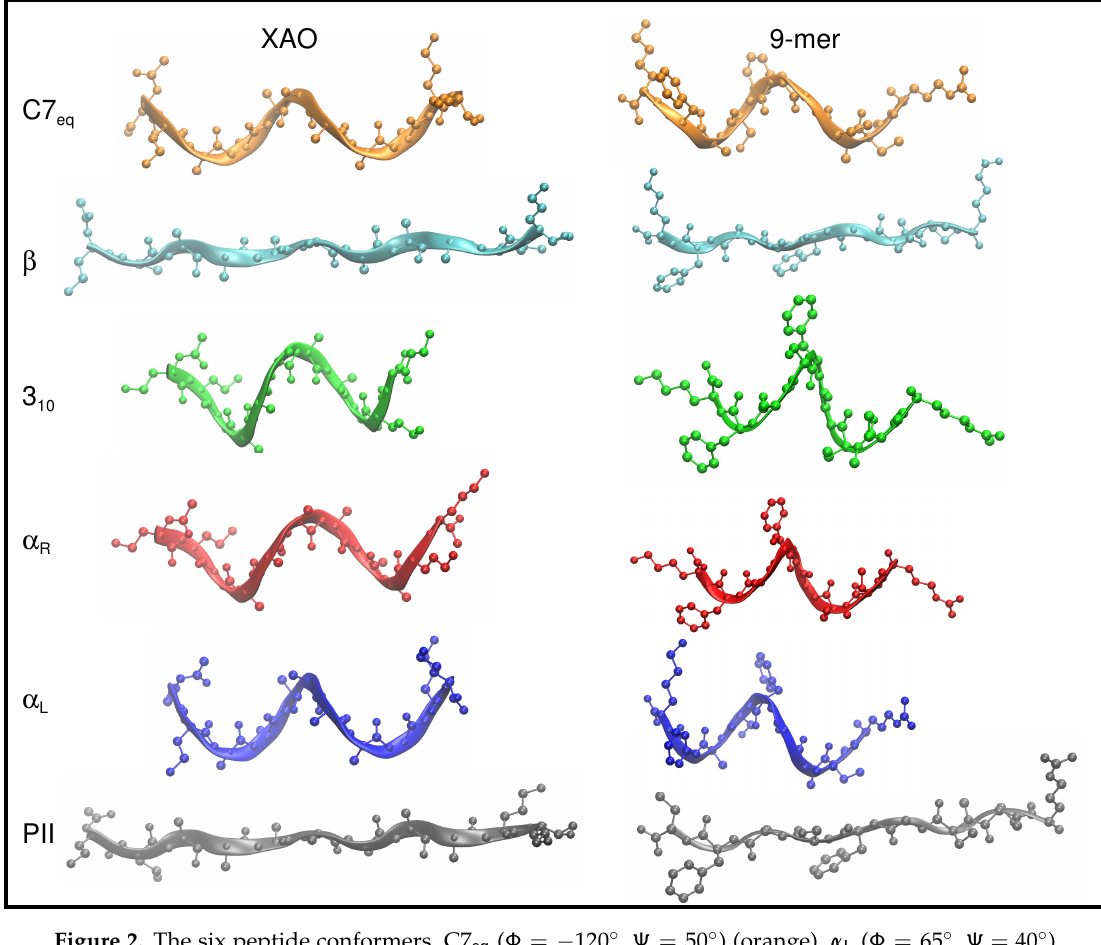
Figure 2. The six peptide conformers, C7 eq ( Φ = − 120 ◦ , Ψ = 50 ◦ ) (orange), α L ( Φ = 65 ◦ , Ψ = 40 ◦ ) (blue), α R ( Φ = − 65 ◦ , Ψ = − 40 ◦ ) (red), 3 10 ( Φ = − 60 ◦ , Ψ = − 30 ◦ ) (green), β ( Φ = − 120 ◦ , Ψ = 130 ◦ ) (cyan), and P II ( Φ = − 60 ◦ , Ψ = 140 ◦ ) (gray), that span the Ramachandan space, are depicted schematically for XAO ( left ) and the 9-mer ( right ). For these illustrations, all Φ - Ψ dihedral angles of the peptide backbones are set to the ideal geometry for each of these six conformers. The peptide backbones are drawn with a ribbon representation to highlight geometric differences. Hydrogen atoms are omitted for